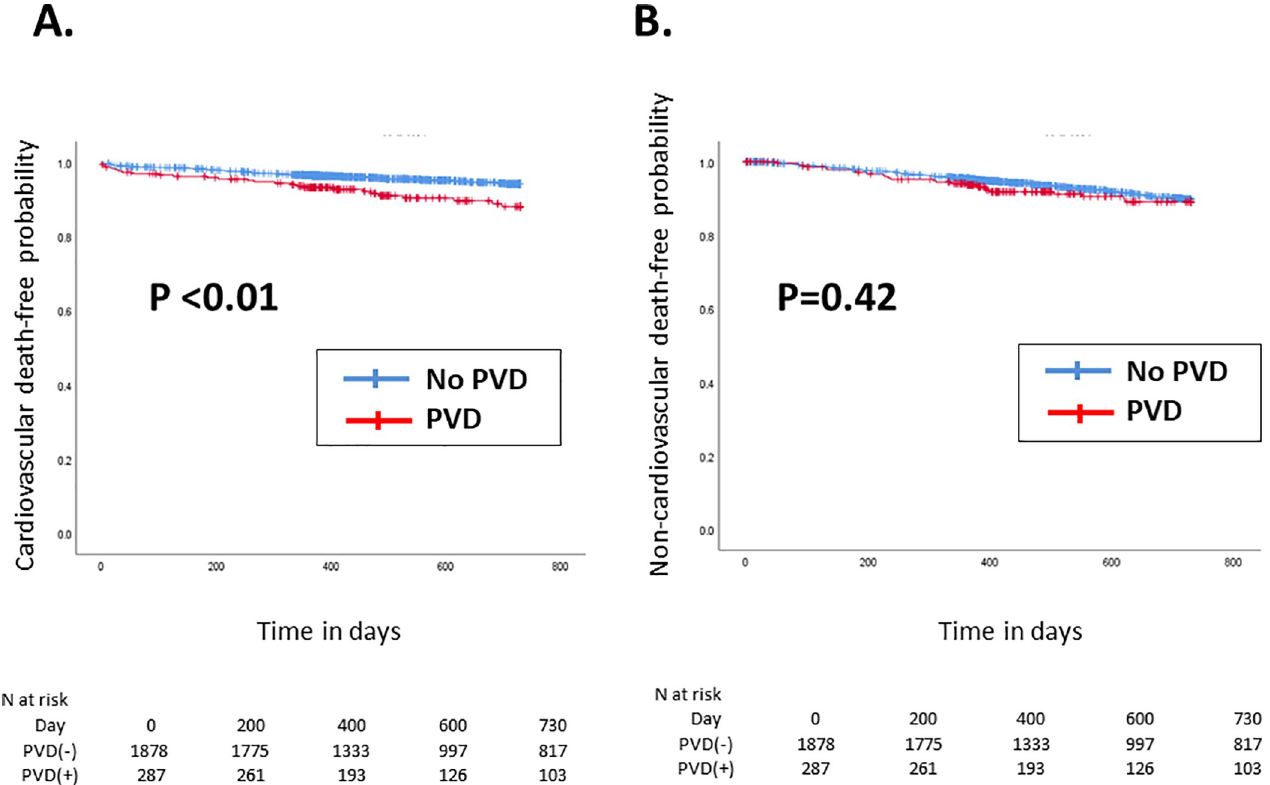
Fig 1. Kaplan–Meier curve of the 2-year (A) cardiovascular death-free and (B) non-cardiovascular death-free rates. The red and blue lines indicate patients with and without PVD, respectively. PVD = polyvascular disease.